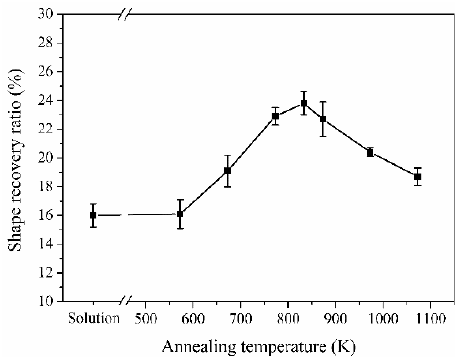
Figure 1. Effect of annealing temperature in one thermomechanical cycle on shape recovery ratio for specimens after being bent by 2.5% at 77 K and then directly heated at 1073 K.